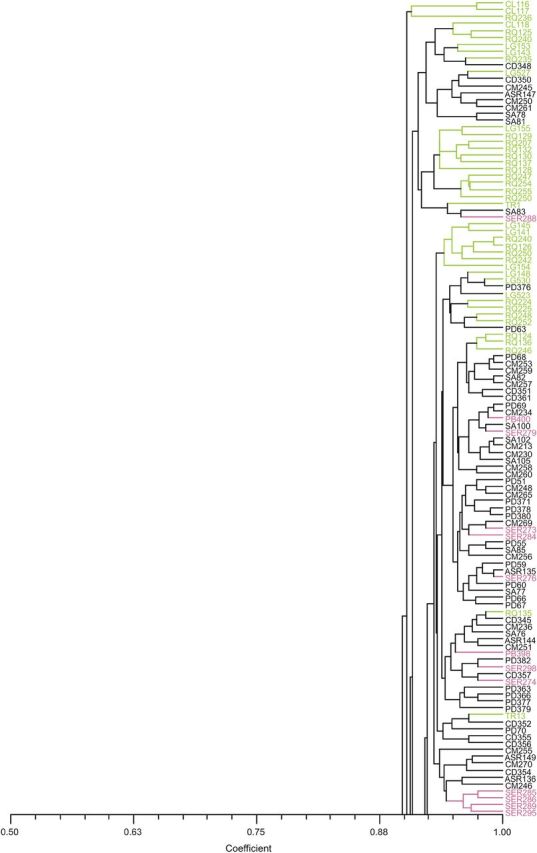
Relationship of 230 P. azorica genotypes from three islands in the Azores: São Miguel (green), Pico (black) and Terceira (pink); and three P. excelsa samples from Madeira island (orange). UPGMA tree based on Dice's coefficient.